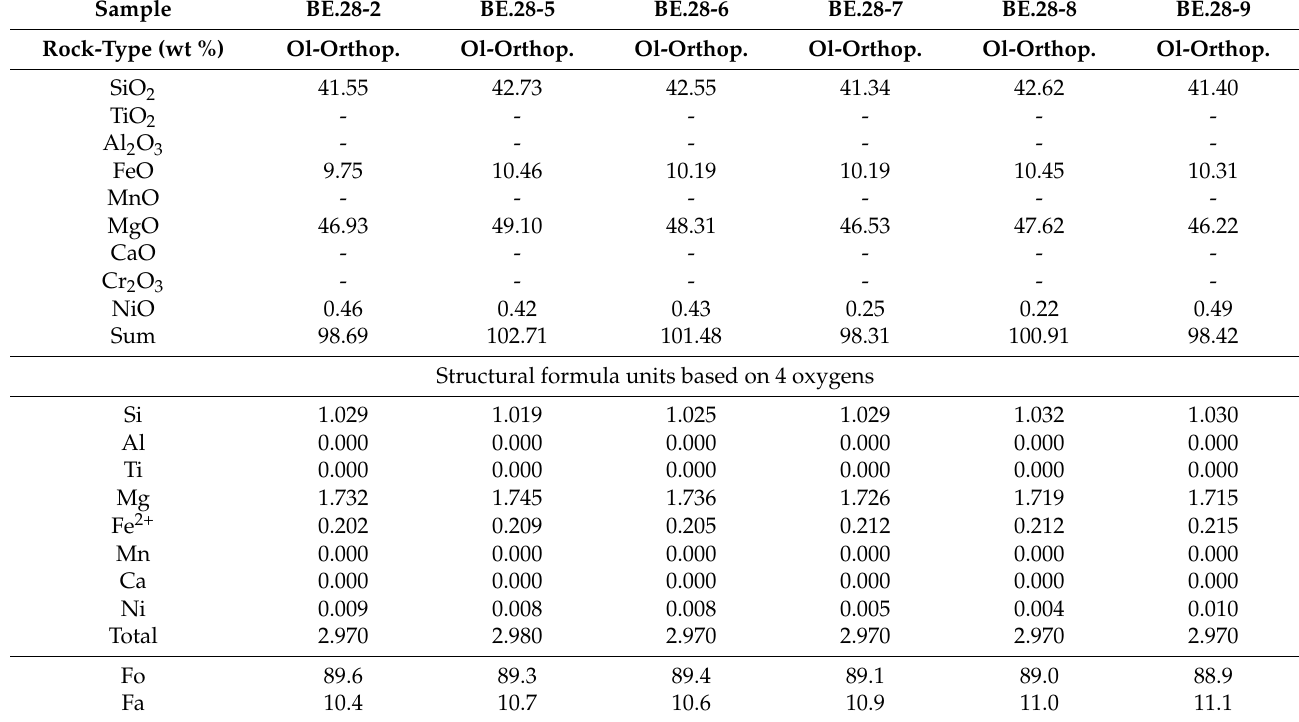
Table 3. Representative electron microanalyses of olivines from Veria-Naousa Ol-orthopyroxenite (-: below detection